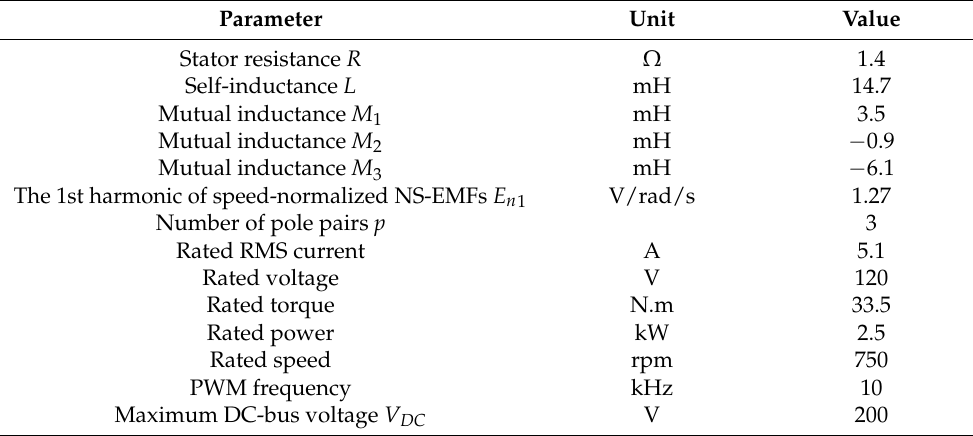
Table 3. Electrical parameters of the experimental test bench (the seven-phase PMSM drive). Parameter Unit Stator resistance R